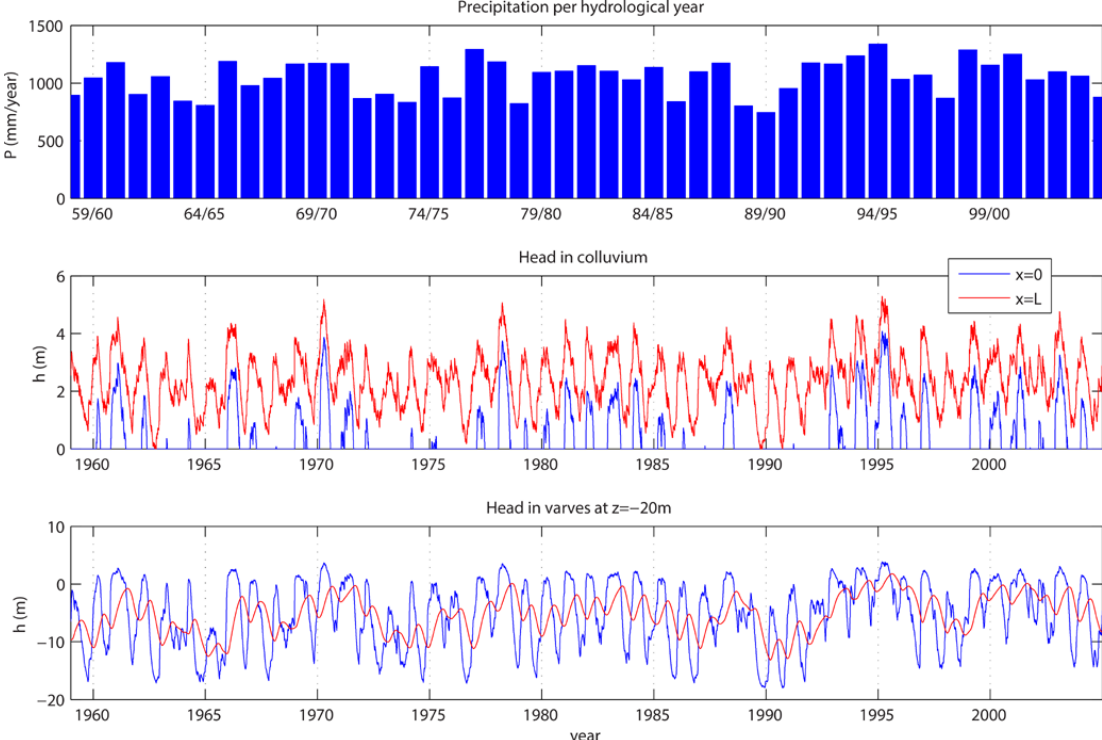
Fig. 8. Total precipitation per hydrological year (1 September–31 August) and calculated head for large standard system for 1959–2004. The head is plotted for x = 0m (next to fissure) and x = L m (halfway between two fissures). Head variations are shown with respect to the bottom of the colluvium/top of the varved